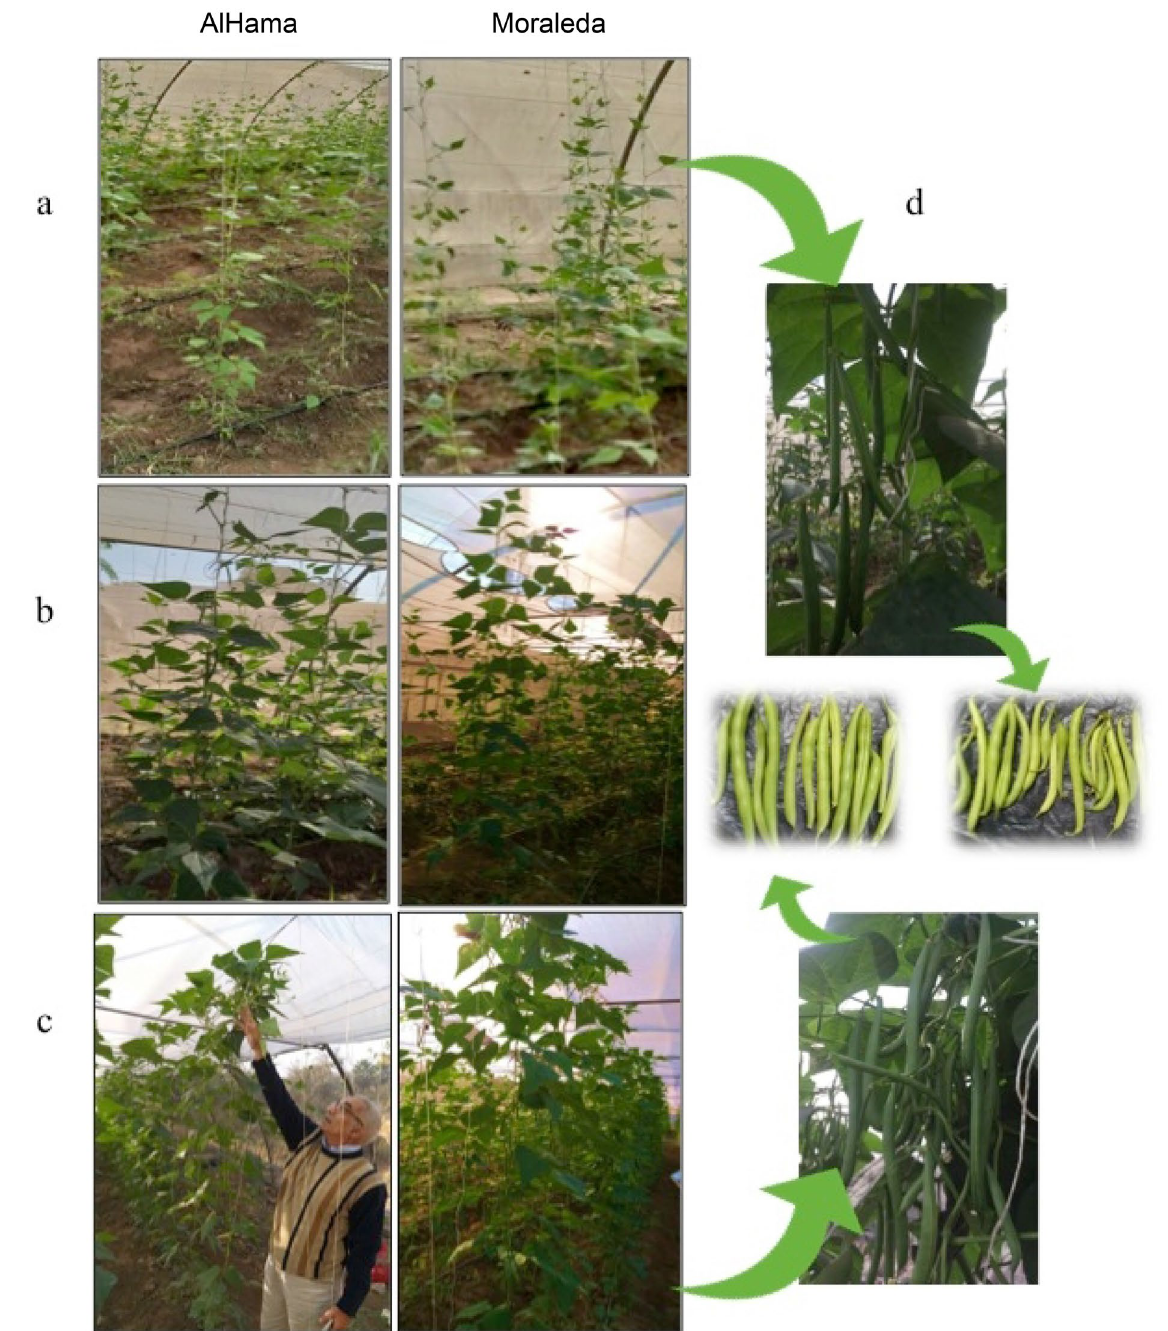
Figure 1. Vegetative and reproduction characteristics of foliar fertilized plants. AlHama and Moraleda plants ( a ) sprayed with water as negative control, ( b ) sprayed with yeast extract as positive control and ( c ) sprayed with growth promoting compounds. ( d ) Control plants gave thing and low yield pods, BSTC treated plants gave higher number and